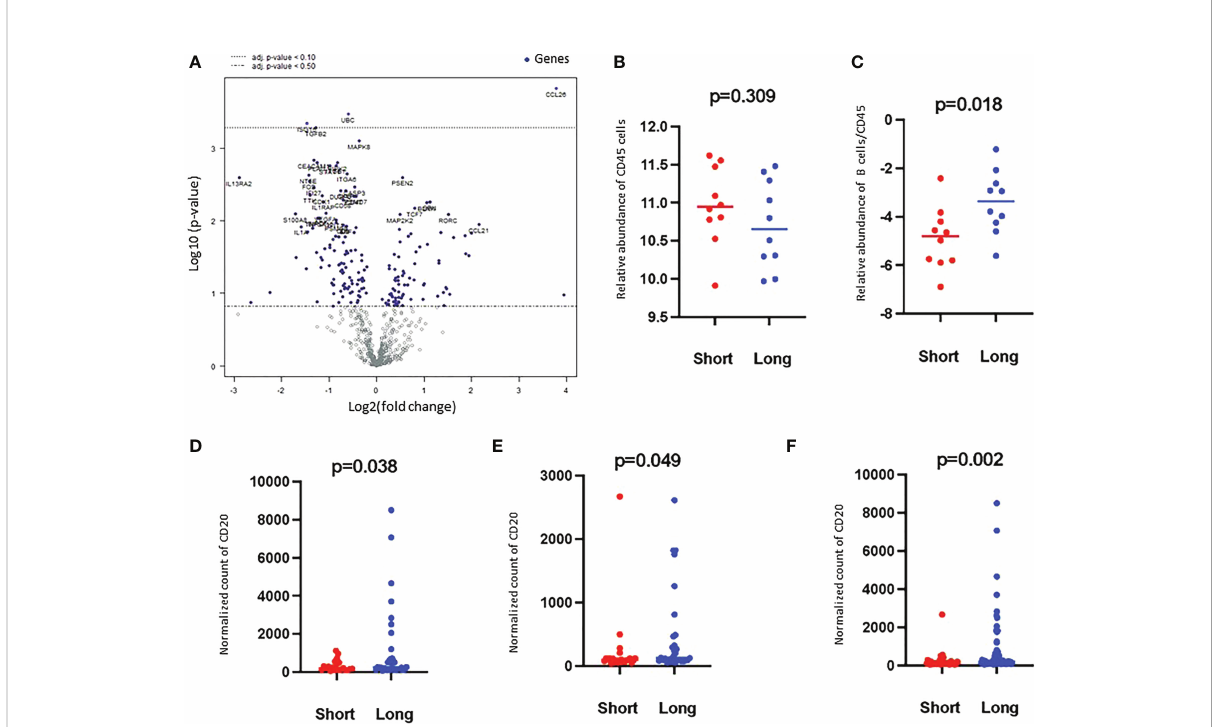
FIGURE 2 Volcano plot of the differentially expressed genes and Higher B cell scores were found in long-term survivors. (A) Volcano plot of the differentially expressed genes in the long- compared to short-term survivors of PDAC. Each dot indicates a detected gene. Three genes were differentially expressed after multiple corrections: CCL26 was overexpressed, and UBC and ISTG were downregulated in long-term survivors. The dotted line represents p -value < 0.1. (B) The relative abundance of CD45 cells in long and short-term survival samples (Independent two- sample t -tests). Each dot presents a sample, the line presents the average expression in each group, y-axis presents the relative expression of CD45 which indicates no signi fi cant differences. (C) The score of B cells relative to the total in fi ltration of CD45+ was found to be signi fi cantly higher in the long-term survival group (Independent two-sample t -tests). Each dot presents a sample, the line presents the average expression of genes identify B cells relative to CD45 in each group, y-axis present the relative expression of B cells/CD45 which indicates a higher abundance of B cells in the long-term survival group. The protein counts of B cell (CD20+) were con fi rmed to be highly expressed in long-term survivors using the GeoMx ™ DSP technology. (D). in the stroma, (E). in between tumor-rich areas and (F). in desmoplastic and tumor-rich areas combined analysis (non-parametric Mann-Whitney U test). Each dot presents an ROI, the y-axis is the normalized counts of CD20 antibody. Blue color presents long- and red color present short-term survival